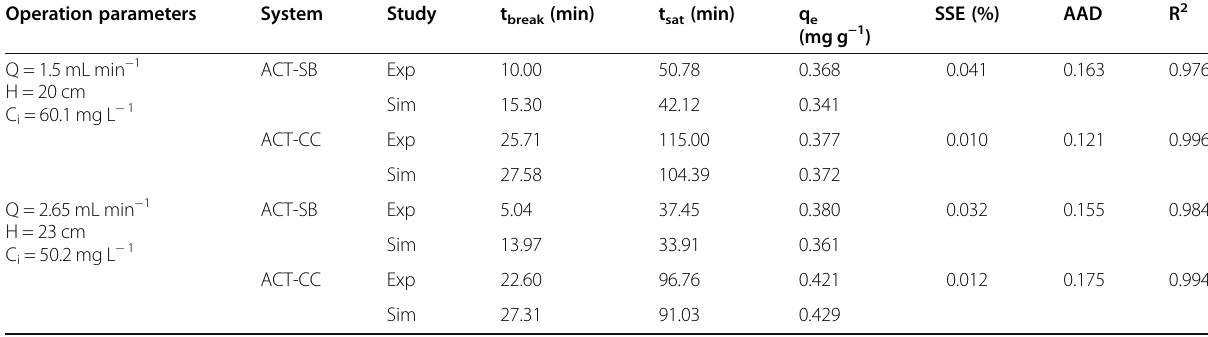
Table 4 Column parameters and error functions for experimental and simulated results Operation